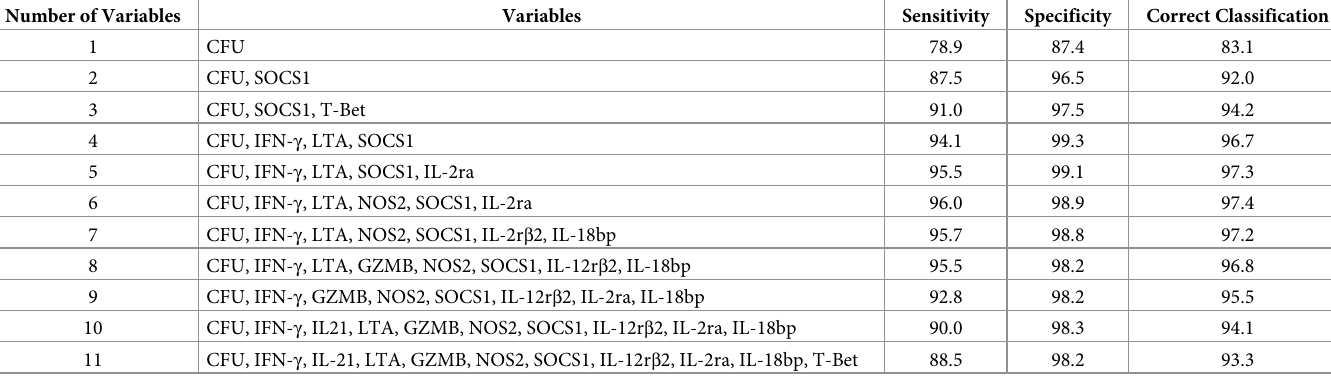
Table 2. Sensitivity, specificity, and correct classification for linear discrimination analyses.